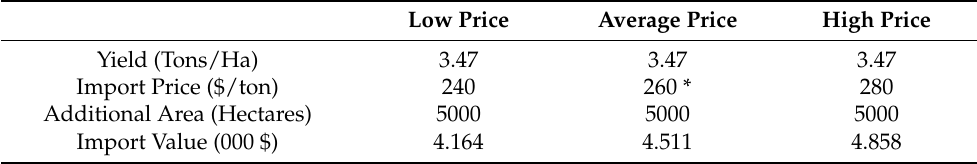
Table 8. Bio-saline wheat production and its foreign exchange value.